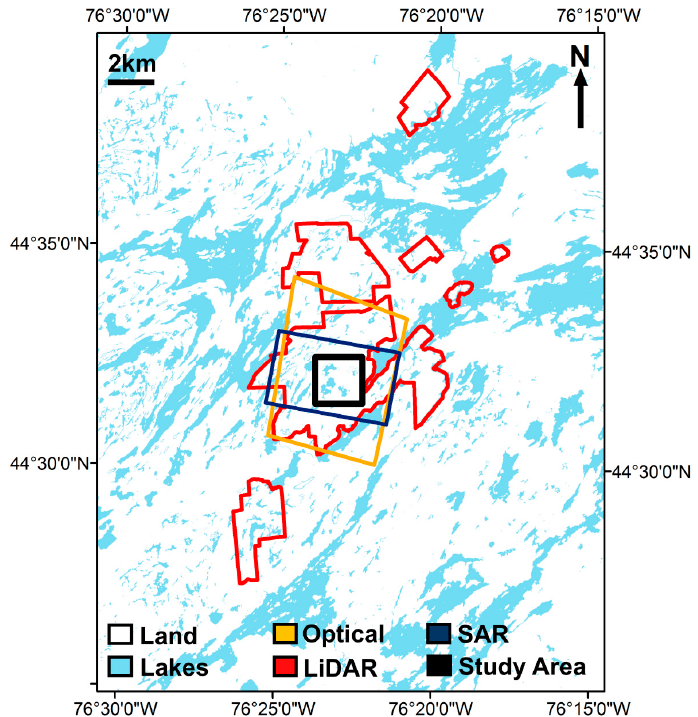
Figure 1. Map showing the extent of synthetic aperture radar (SAR) scenes (dark blue), light detection and ranging (LiDAR) airborne survey (red), optical imagery (yellow), the study area (black), lakes (blue) and land (white) mapped by the Ontario Ministry of Natural Resources.